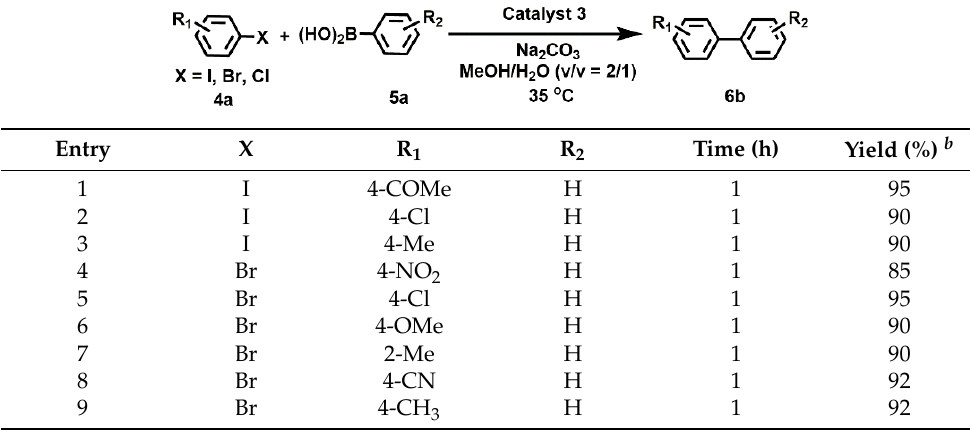
Table 2. The scope of the 3-catalyzed Suzuki-Miyaura cross-coupling reaction a .